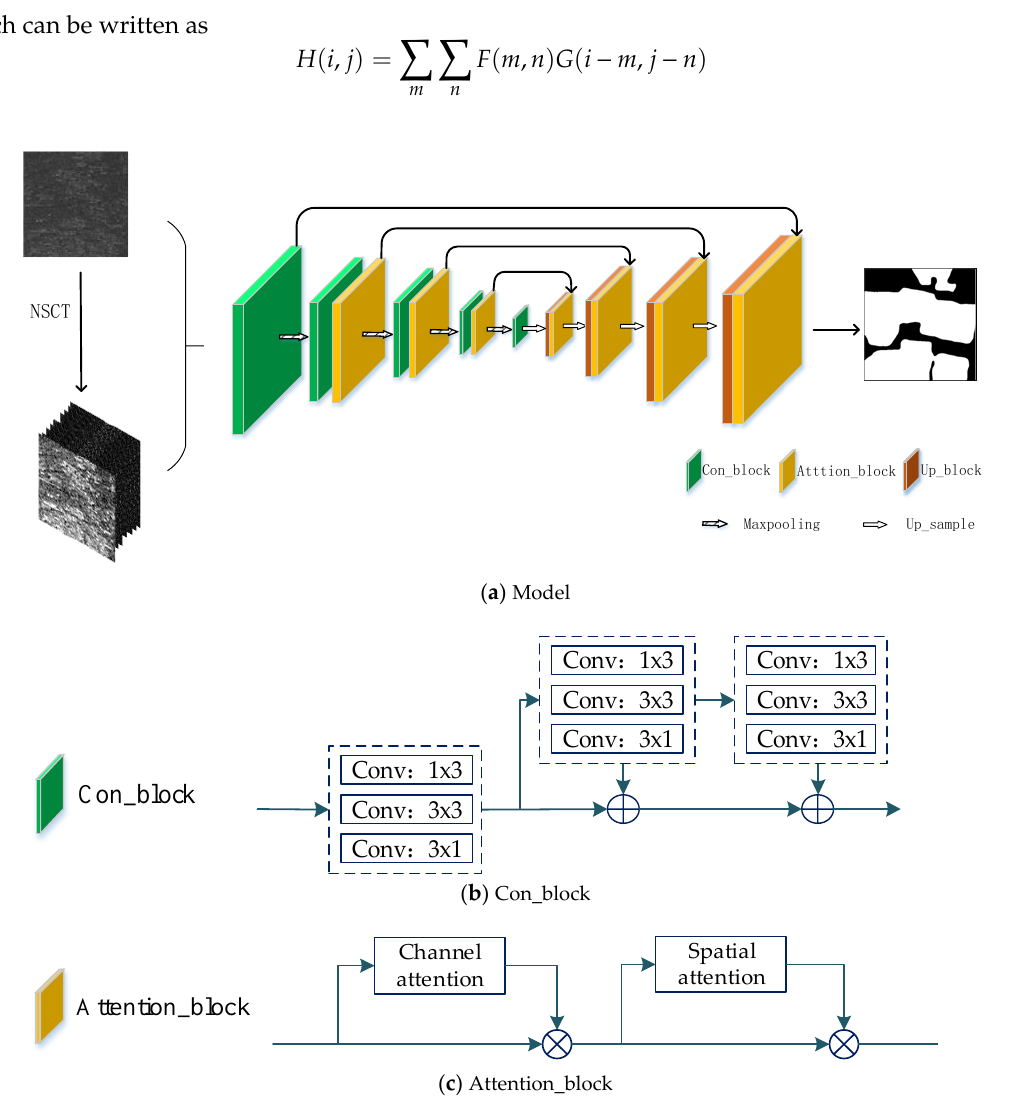
Figure 7. The model for the marine raft aquaculture area extraction task. ( a ) The overall model structure; ( b ) the Con_block with an asymmetric and multiscale structure; ( c ) the structure of the Attention_block with channel attention and spatial attention.